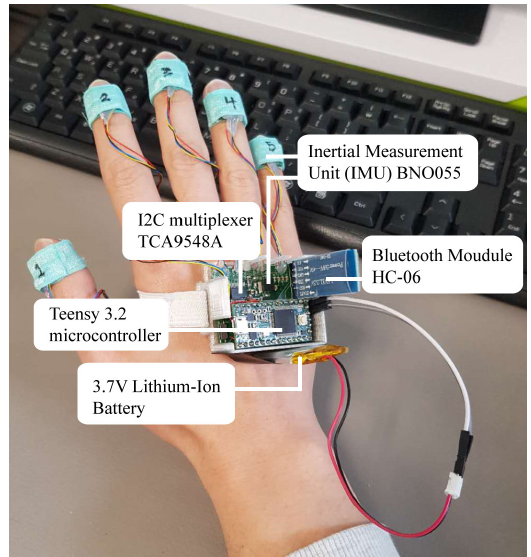
Figure 4. Proposed smart wearable ASL gesture recognition